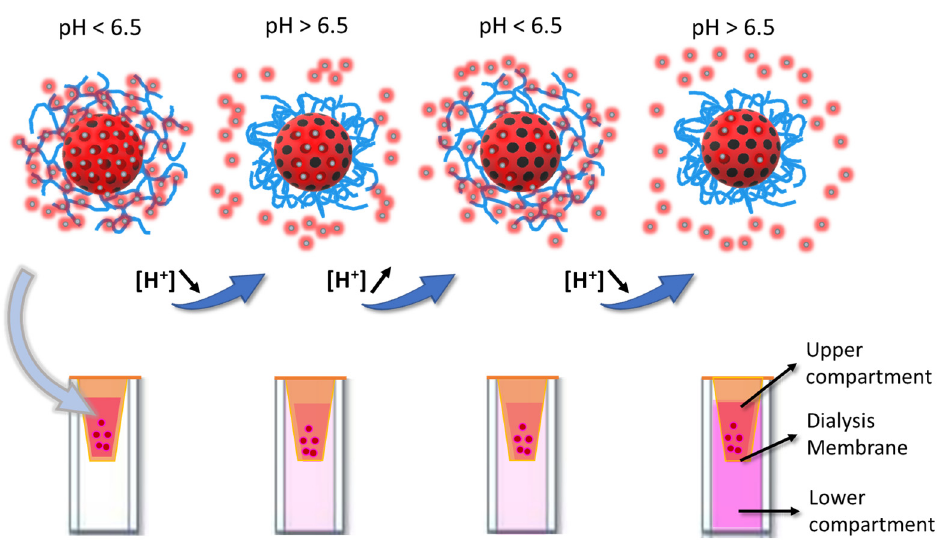
Figure 4. Schematic representation of SRB (black/red dots) release from SRB-loaded nanocarriers. The polymer is expanded at low pH values and collapses by increasing the pH. When the polymer is expanded (low pH), SRB diffuses from the pores but is trapped in the polymer network due to the electrostatic interaction with the protonated amine groups of the polymer shell. By increasing the pH, the cargo is released because the polymer collapses and the electrostatic interaction with the cargo is lost due to deprotonation of the polymer amine groups. By modulating the pH value, the process can be repeated. The system behaves like a nanopump, squeezing out the cargo with a sponge-like mechanism in response to the pH modulation.